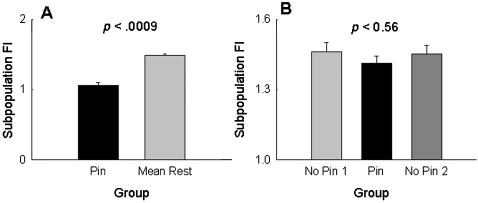
Experiment: effect of pinning at the subpopulation level, averaged over four replicate metapopulations. (A) The mean FI of the pinned subpopulation was significantly less than the mean of the remaining eight subpopulations. (B) There was no difference in the average FI of the pinned group (the pinned subpopulation and its two immediate neighbors) and the two neighboring groups on either side (No Pin1 and No Pin 2). This suggests that the stabilized subpopulation could not stabilize the dynamics of the pinned group vis-à-vis the two neighboring groups. Error bars indicate standard errors around the mean in this and all subsequent figures.